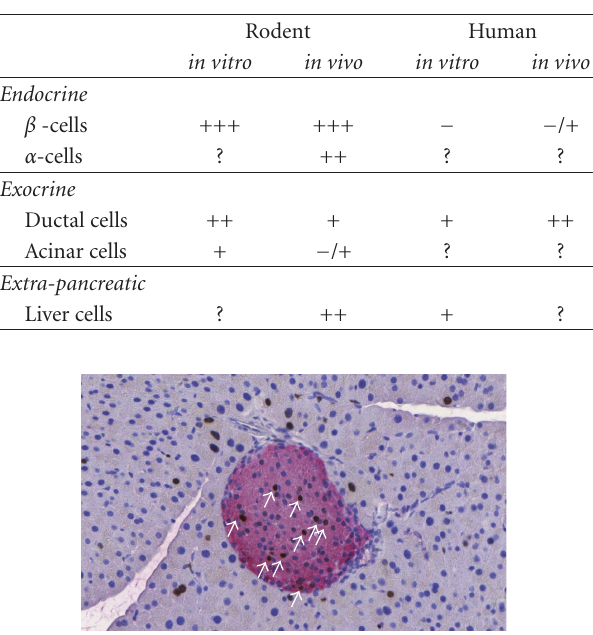
Figure 1: Section of murine pancreas stained with anti-insulin (red) and anti-BrdU (brown) antibodies. C57BL/6 mice were on a high-fat diet for 6 weeks. BrdU was injected for one week by s.c. injections, thereby labeling all proliferating cells. A number of replicating β -cells (arrows) and acinar cells are